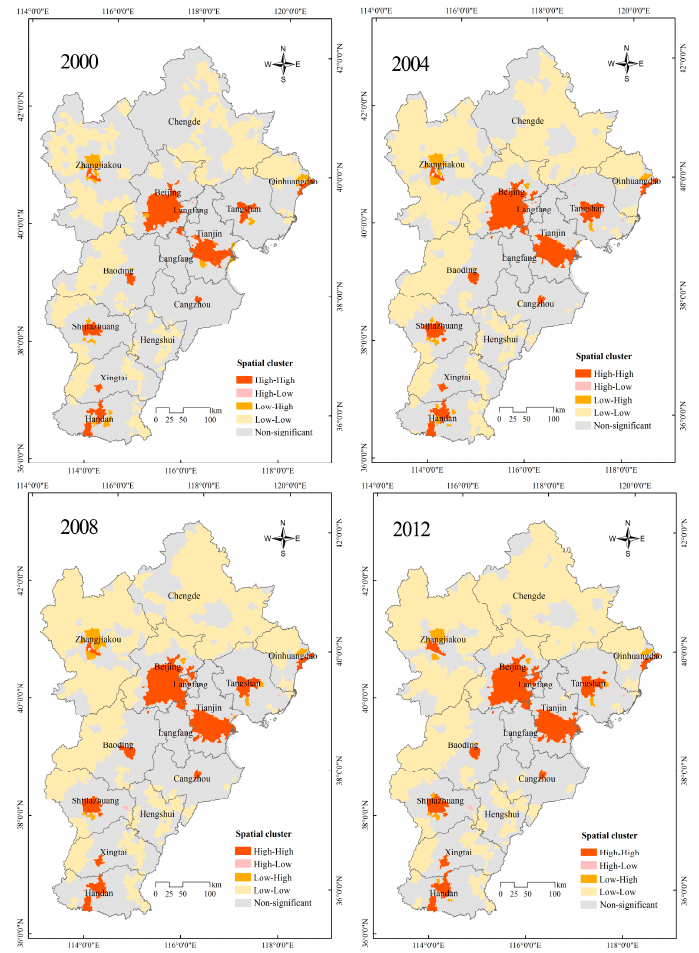
Figure 5. Spatial cluster of urban development in Beijing-Tianjin-Hebei urban agglomeration during 2000–2012.